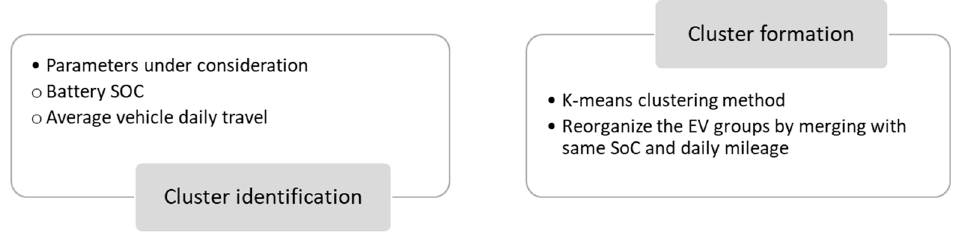
Figure 16. Overview of EV battery clustering based on SOC and daily mileage [76].